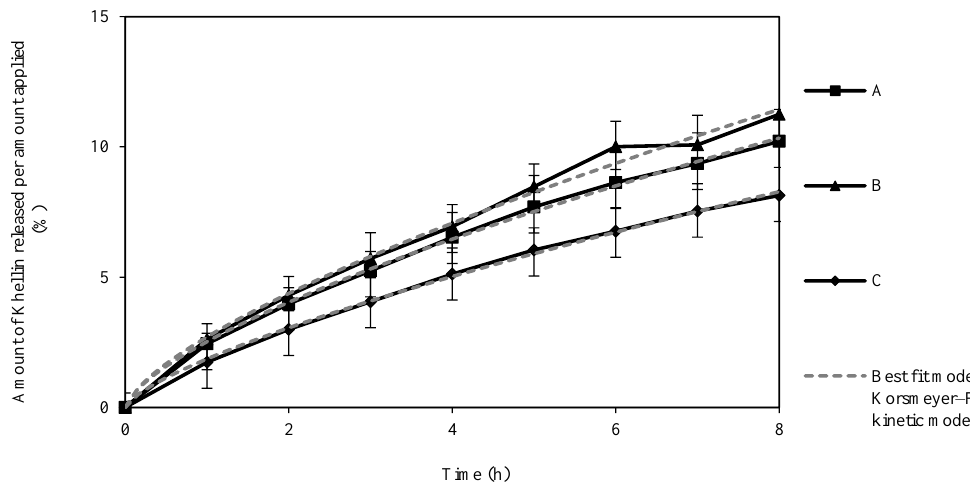
Figure 5. Release profiles of KHE from A, B and C oil-in-gel emulsions through Tuffryn ® membrane, during 8 h (mean ± SD, n = 3), to which the Korsmeyer – Peppas kinetic model was adjusted.